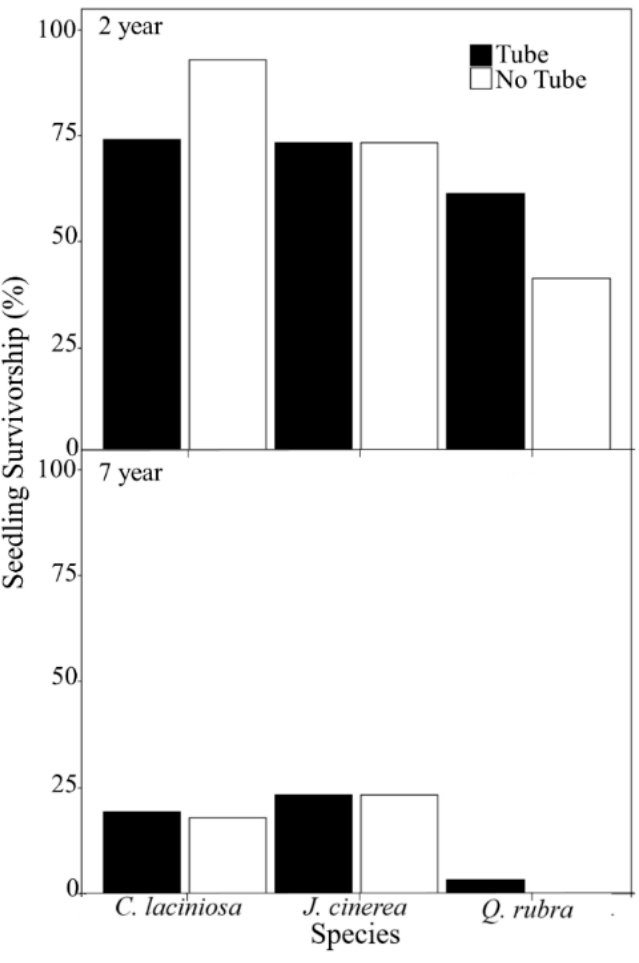
Figure 3. Percentage of seedling survival as a function of tree tubes for three species of tree seedlings planted in a temperate forest understory in southwestern Ohio, USA, during a forest restoration experiment. Seedlings planted without tubes are represented by white bars and trees planted with tubes are represented by black bars. There were no statistical differences among survivorship with or without tree tubes for C. laciniosa or J. cinerea ( p > 0.05), but Q. rubra seedlings had higher survivorship with tree tubes after two years ( p = 0.020).